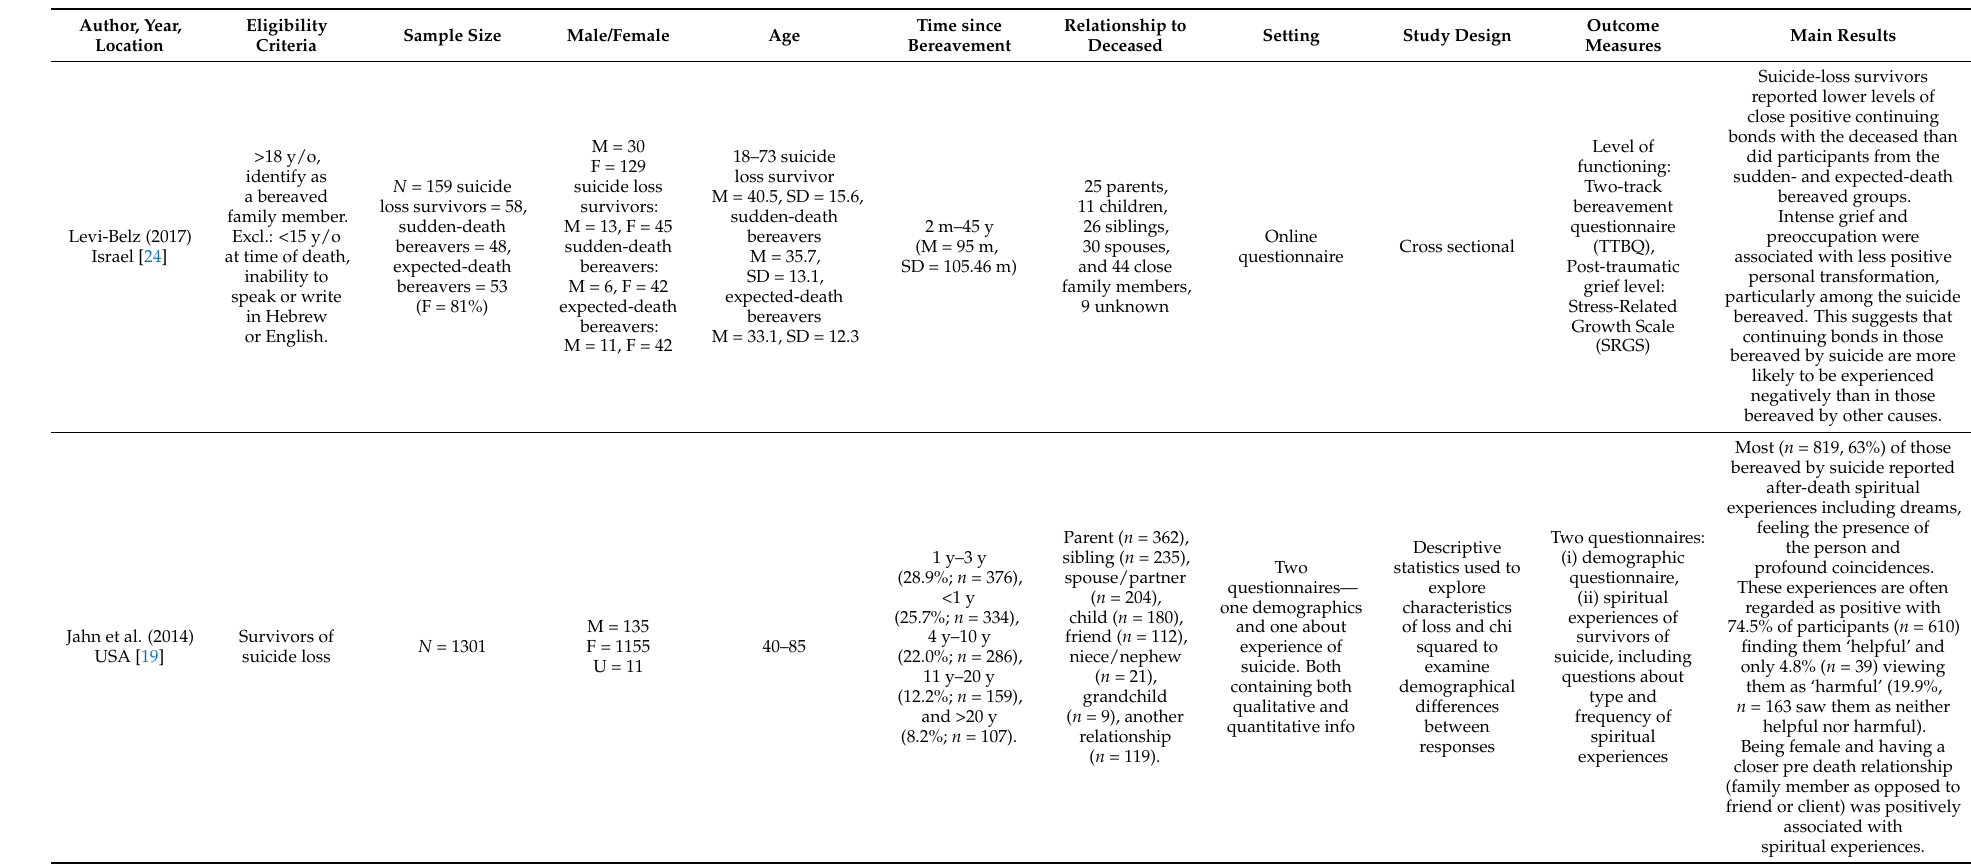
Table 1. Summary of quantitative